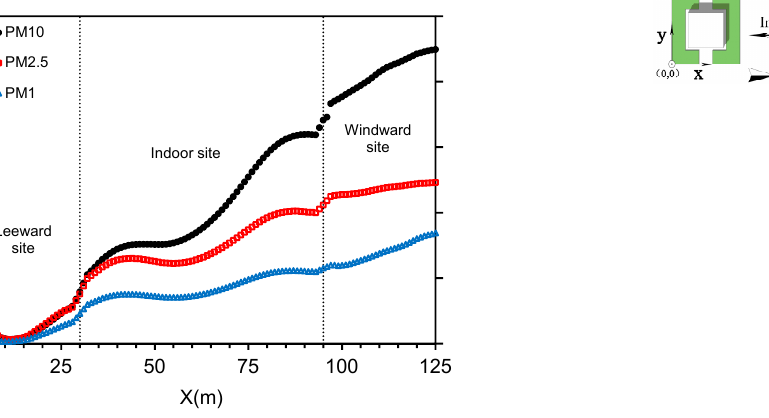
Figure 9. Particle concentrations along the horizontal plane at y = 53 m and z = 1.5 m in the baseline scenario.